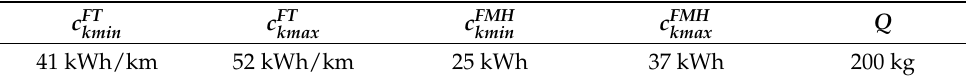
Table 3. Each bin’s capacity was 100 kg. The maximum allocated time span T max = 3 h. Table 3. Truck